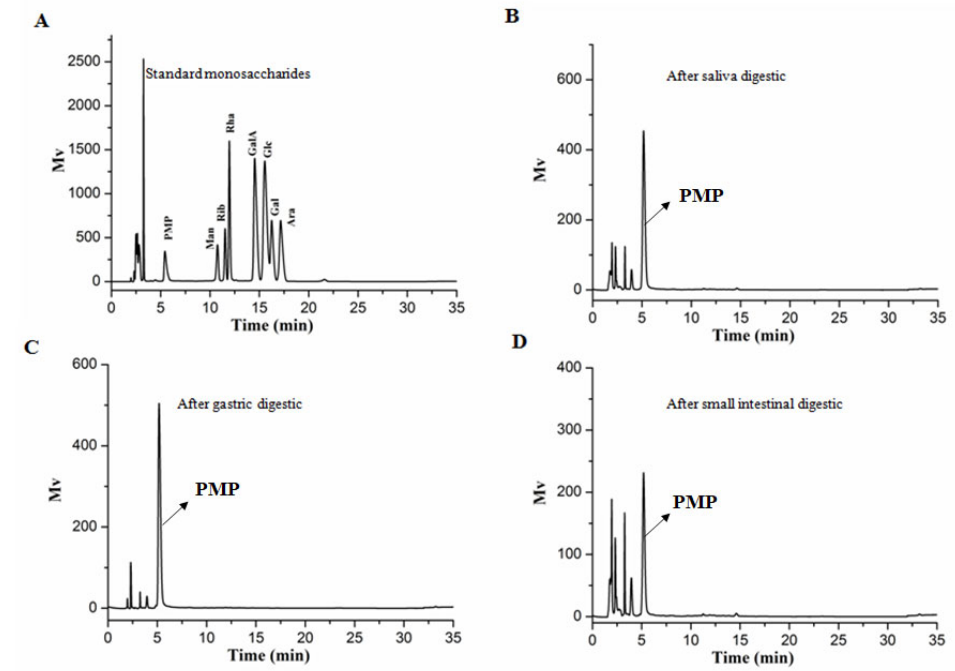
Figure 2. Changes in monosaccharides released from AABP-2B during digestion. Monosaccharide standards ( A ); salivary digestion of AABP-2B for 0.5 h ( B ); gastric digestion of AABP-2B for 4 h ( C ); small-intestinal digestion of AABP-2B for 4 h ( D ). PMP, 1-Phenyl-3-methyl-5-pyrazolone; Man, mannose; Rib, ribose; Rha, rhamnose; GlaA, galacuronic acid; GlcA, glucuronic acid; Glc, glucose;